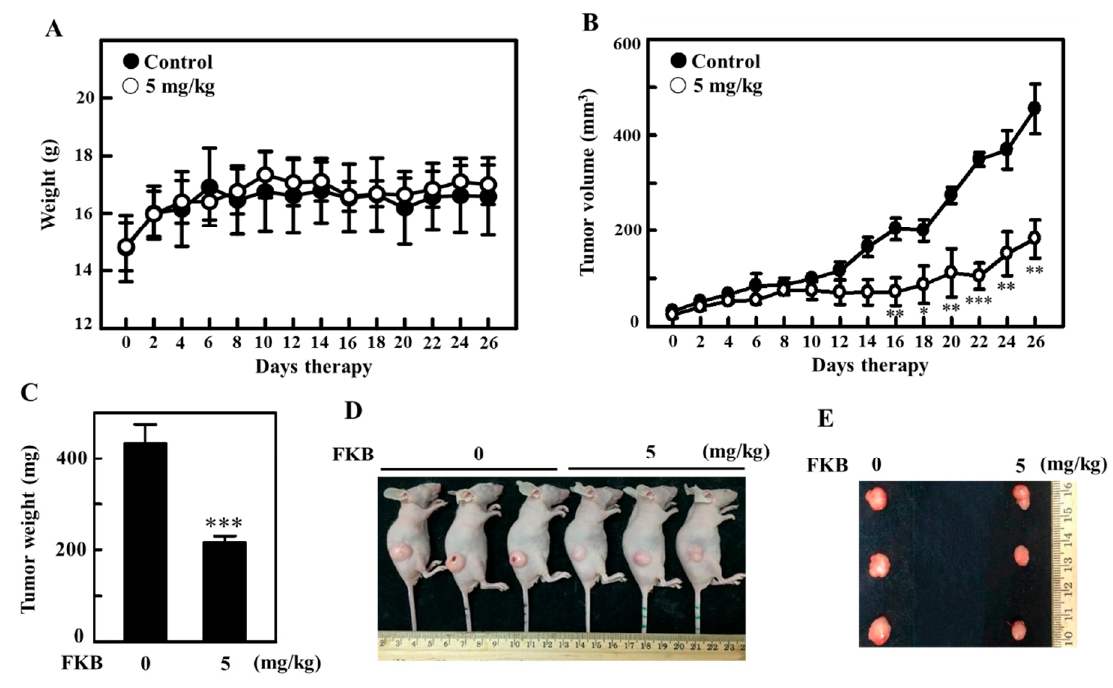
Figure 12. FKB-mediated in vivo inhibition of tumor growth in A375 xenograft athymic nude mice. Athymic nude mice were subcutaneously xenografted with A375 cells as described in the methods section. Mice were subjected to the vehicle (control) or FKB (5 mg/kg, intraperitoneal) for 26 days of therapy. ( A ) The body weight (in grams) and ( B ) tumor volumes (in mm 3 ) were measured every 2 days. ( C – E ) On the twenty sixth day, animals were photographed, sacrificed and their tumor tissues were removed and weighed. Results are expressed as the mean ± standard deviation (SD) of three experiments. Statistical significance was assigned as * p < 0.05, ** p < 0.01, and *** p < 0.001 as compared to vehicle-treated control group.